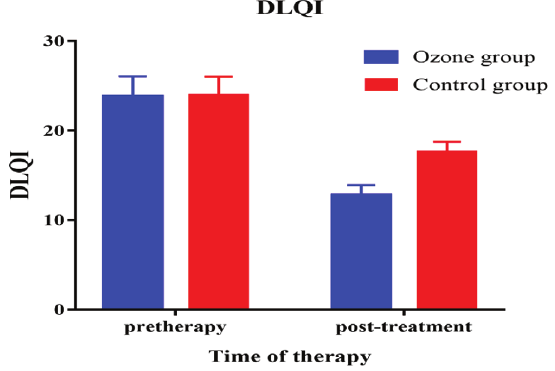
Figure 5. Comparison of DLQI scores before and after different treatments (score) box